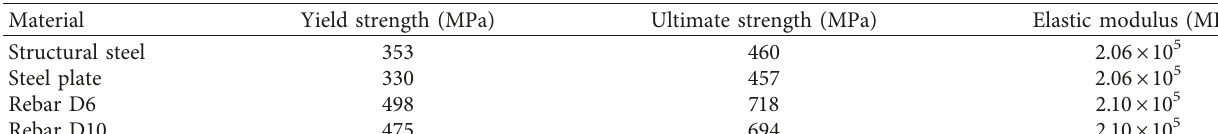
Figure 10: Loading protocol of the numerical analyses. Table 5: Strengths of steel and rebars.